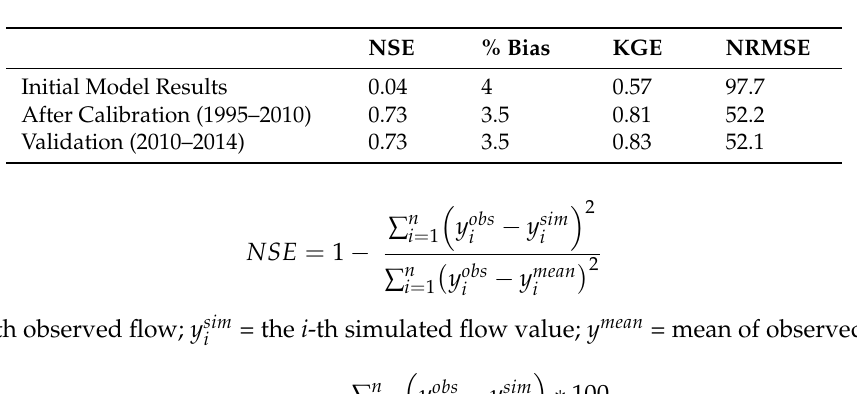
Table 2. Final model goodness of fit statistics based on daily streamflow for Nash-Sutcliffe